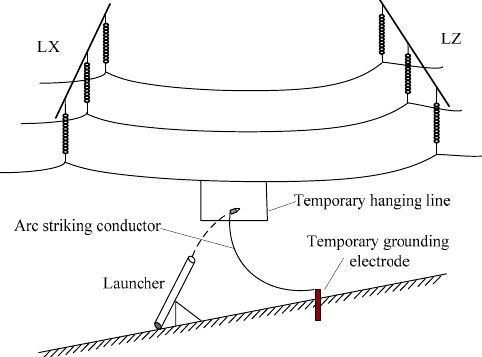
Figure 17. Basic principle of artificial short circuit grounding test.